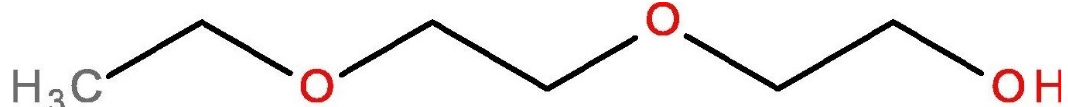
Figure 1. Chemical structure of drug and skin promoters. ( A ) Caspofungin [27], ( B ) Azone, [20] and ( C ) diethylene glycol monoethyl ether (Transcutol) [28].